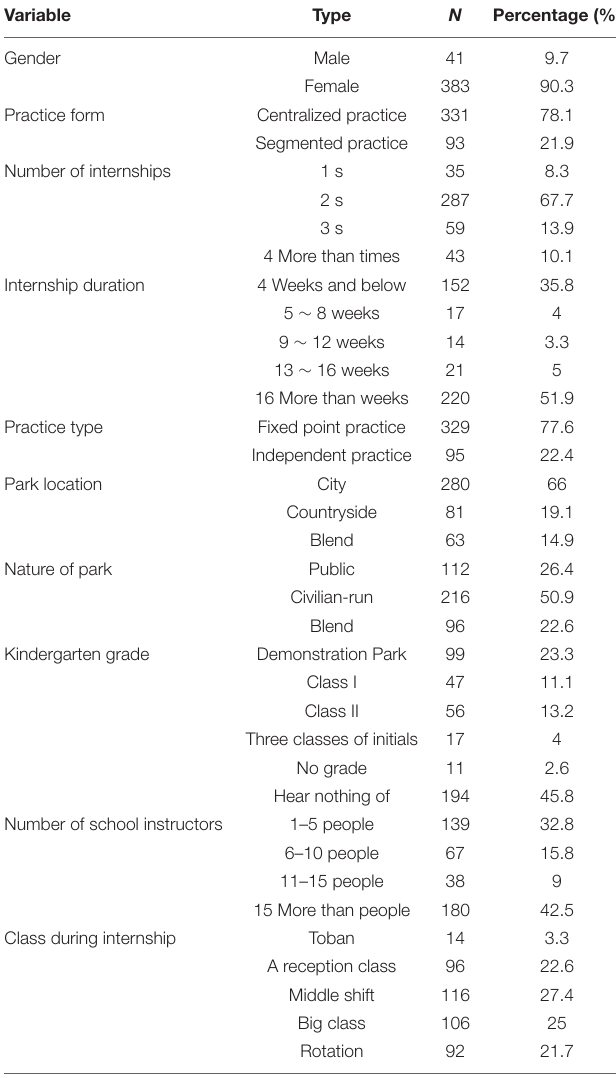
TABLE 1 | General features of the participants (Total N =